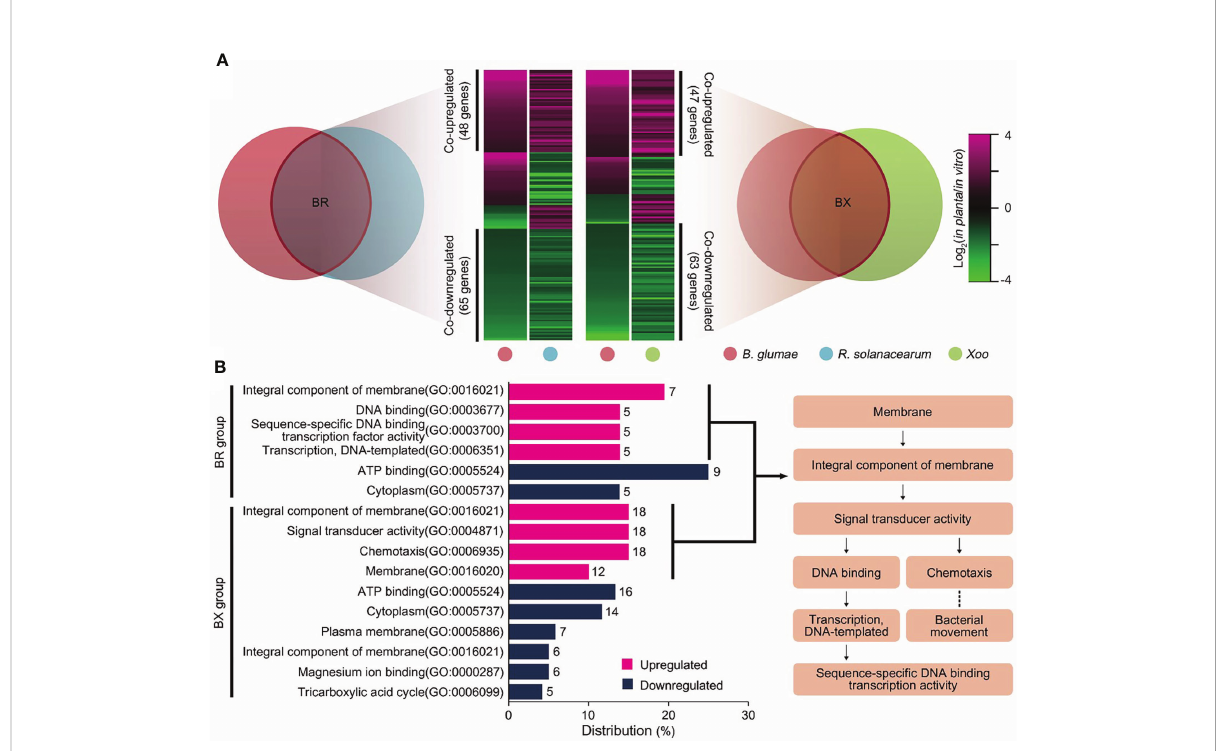
FIGURE 2 Co-expression patterns of in planta transcriptomes in the three pathogens (A) Expression patterns from pairwise orthologous groups are shown as heatmaps. Each column represents a pathogen, and each row represents a DEG. The relative expression level of DEGs is presented using a fold change value, shown as log 2 ( in planta / in vitro ). Red and green gradients indicate an increase or decrease in gene expression, respectively. Co- expression patterns that followed identical tendencies among plant pathogens are shown on the y -axis with their gene scale. (B) Co-upregulated (red) and co-downregulated (blue) DEGs were subjected to GO analysis. GO terms in the upper and lower parts of the bar chart are enriched in the BR and BX orthologous groups, respectively. The x -axis shows the distribution of each term with gene count among all GO terms. The fl owchart illustrates the cascade of co-upregulated GO terms associated with signal transduction considered in our prediction